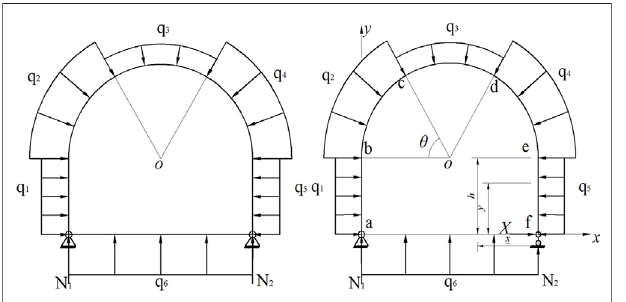
FIGURE 7 | Single arch truss analysis diagram by external forces.